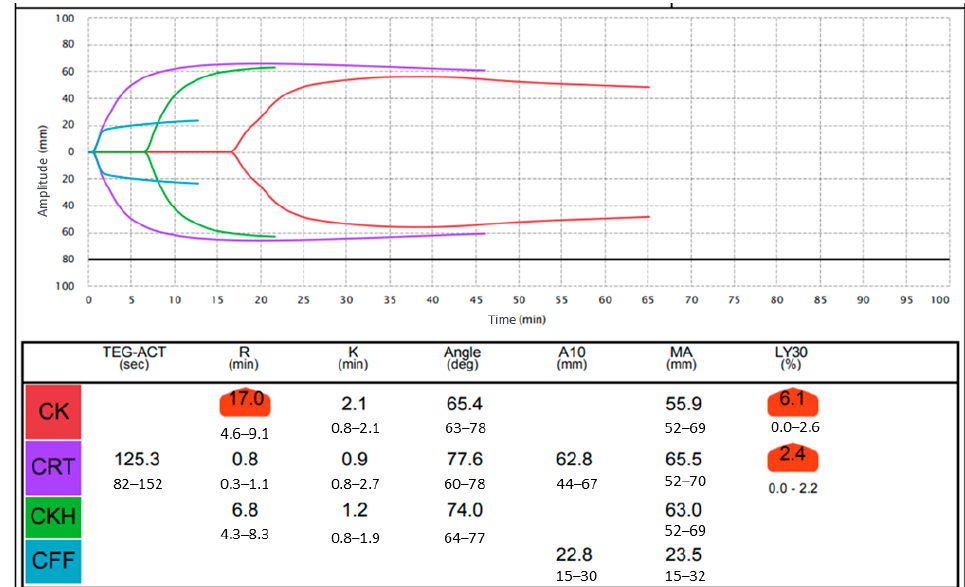
Figure 2. A typical trace of TEG6s ® parameters in a patient who developed deep venous thrombosis at 12 weeks of gestation and started heparin therapy; the red line is citrated kaolin (CK), the purple line is citrated rapidTEG (CRT), the green line is citrated kaolin with heparinase (CKH), and the blue line is citrated functional fibrinogen (CFF). The difference between CK and CKH clearly shows the effect of heparin administration. R = reaction time, K = clot formation time, Angle = alpha angle, MA = maximum amplitude, LY30 = lysis at 30 min.